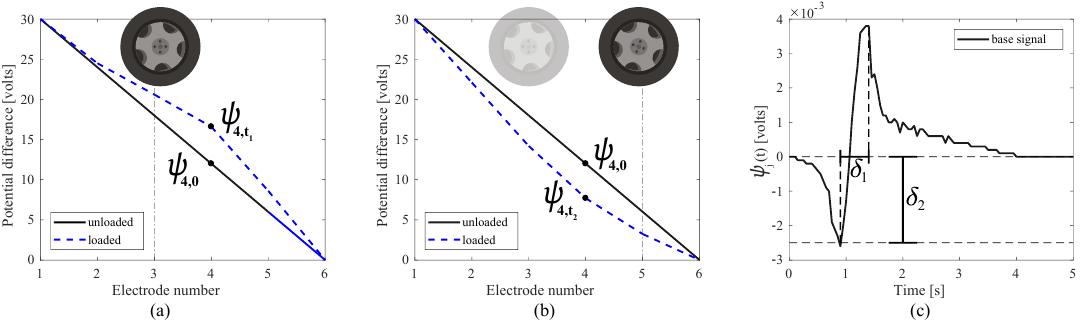
Figure 3. ( a ) The unloaded and loaded (at time t ) voltage distributions across electrodes ( a ) for the axle located between the 1st and 4th electrodes; and ( b ) for the axle located between the 4th and 6th electrodes. ( c ) Typical basis signal ψ ( t ) obtained from the passing of an